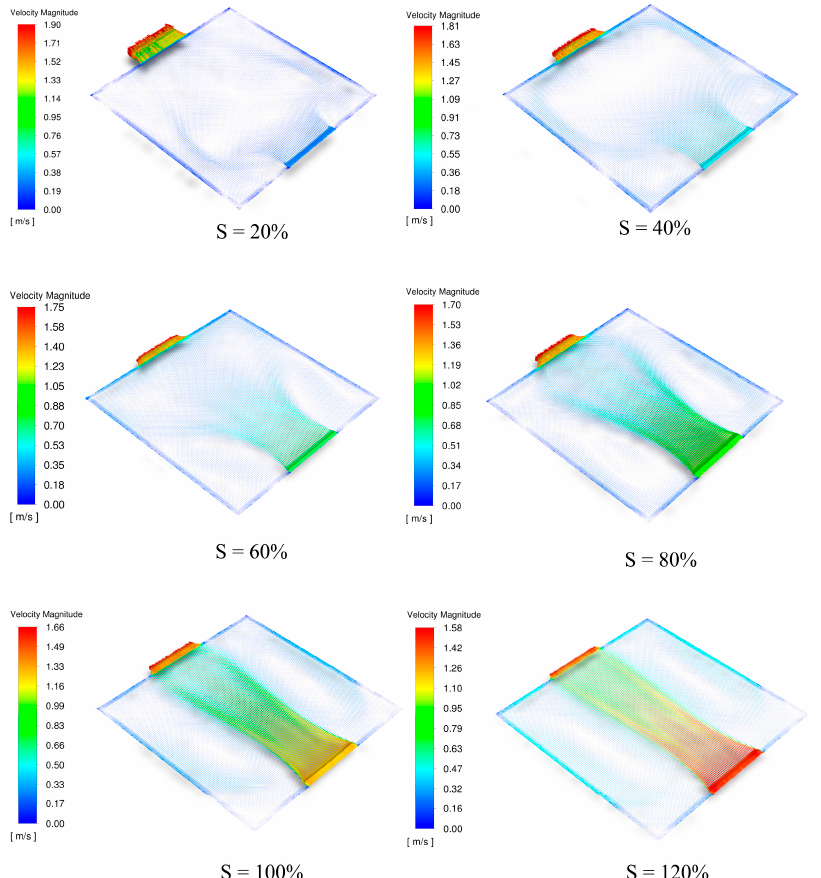
Figure 8. The internal velocity field distribution maps of the wall-type solar chimney under different S-values.